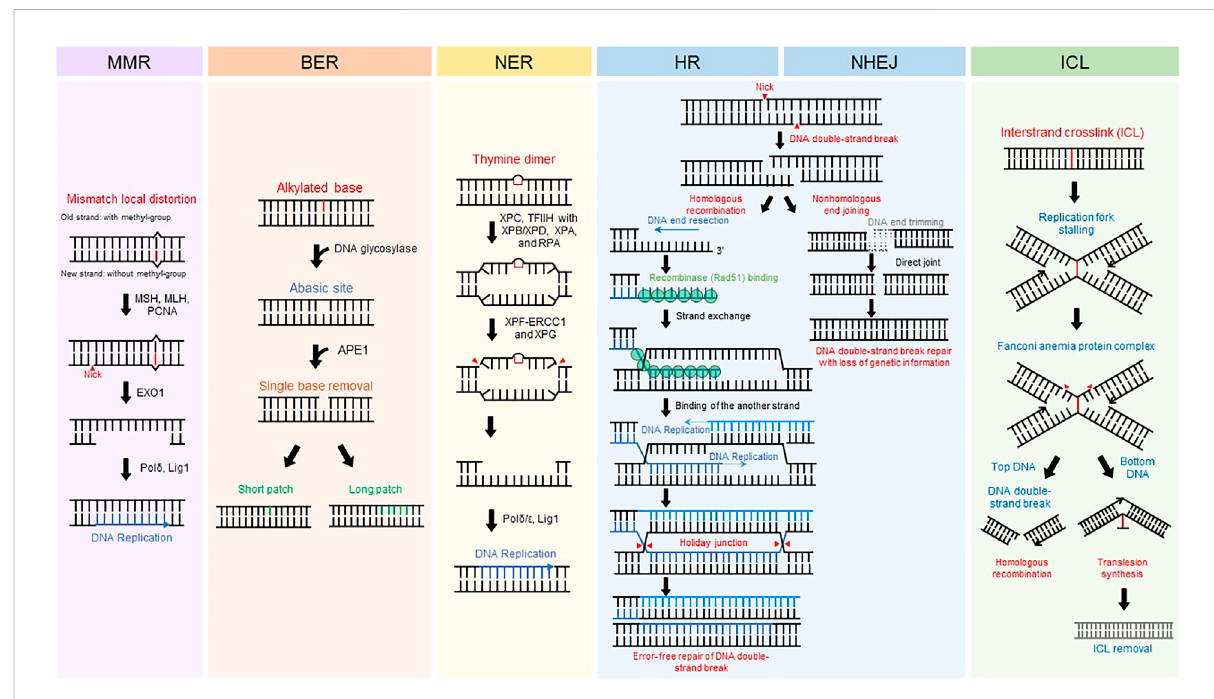
FIGURE 1 DNA repair mechanisms. Representative eukaryotic DNA repair pathways and their associated proteins. Schematic procedure of each eukaryotic DNA repair pathway is